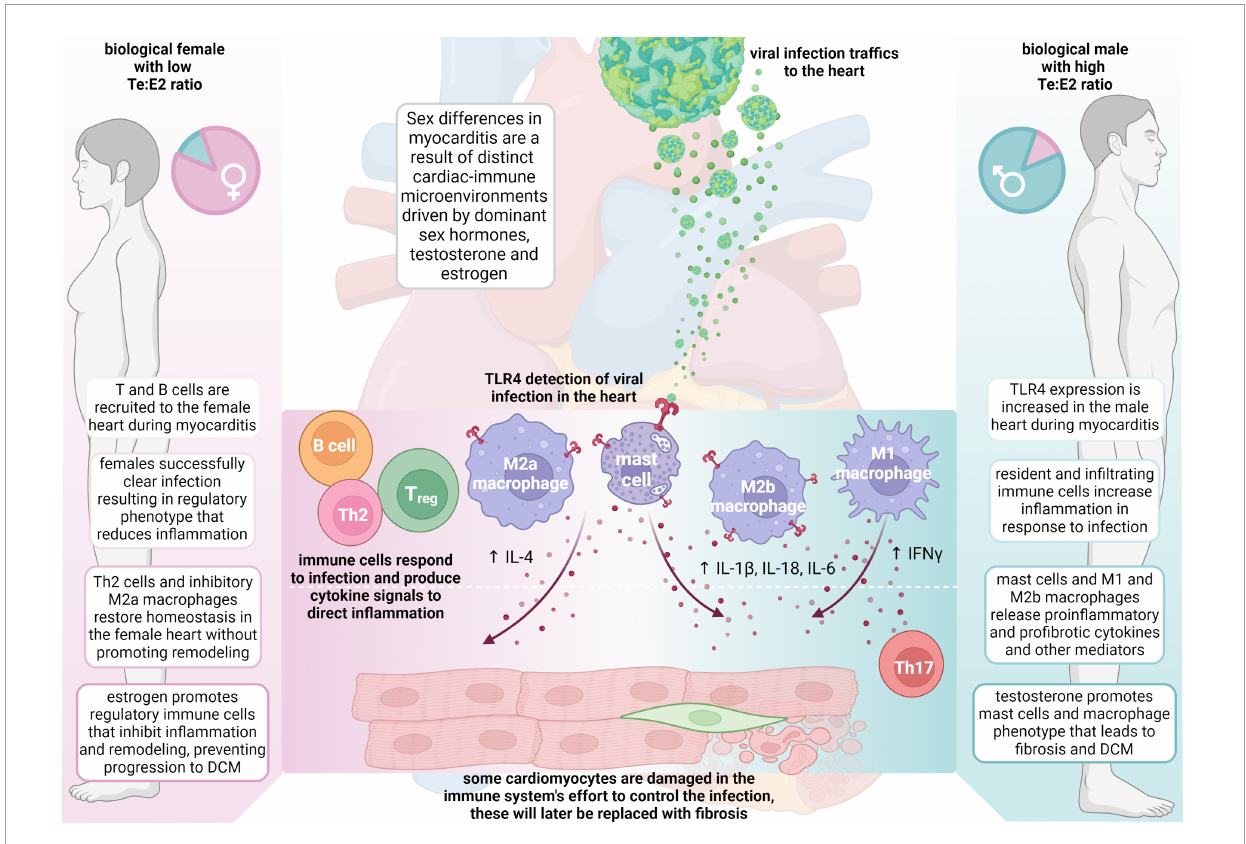
FIGURE1 Sex differences in the pathogenesis of viral myocarditis and DCM. The summary of mechanisms of sex differences are primarily based on the Fairweather model of viral myocarditis (see text for full description). DCM, dilated cardiomyopathy; E2, estrogen/17 β -estradiol; interferon; IL, interleukin; , male; Te, testosterone; Th, T helper cells; TLR, Toll-like ♂